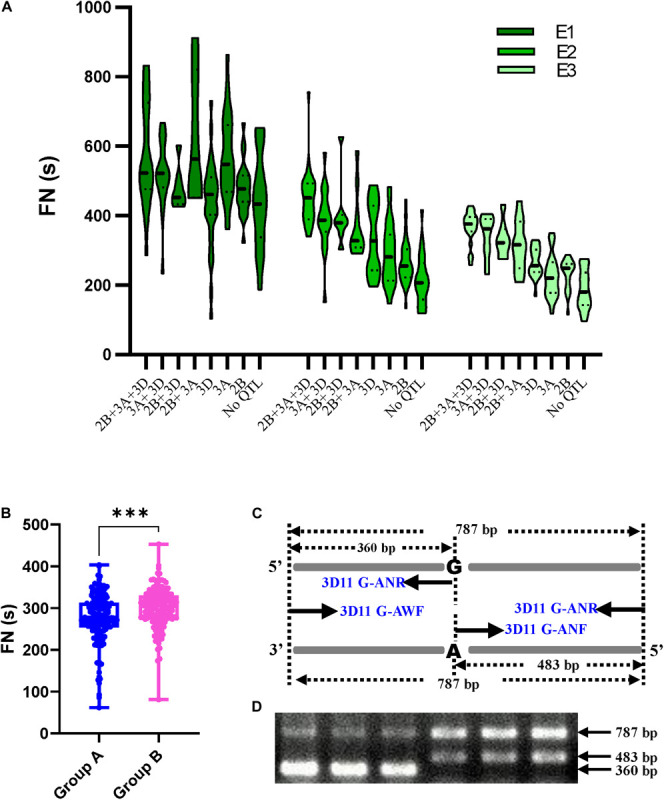
The effects of major QTLs for FN and marker development. (A) Effects of QTL combinations on FN of RILs in different environments shown by violin plot. (B) The effects of QFN.cib-3D on FN in RILs derived from Chuanmai 42 × Kechengmai 4. Group A denotes alleles that are the same as those of Kechengmai 4 and Chuanmai 39; group B denotes alleles that are the same as those in Chuanmai 42. (C) The principle of PCR-CTPP for QFN.cib-3D. “A” and “G” denote the SNPs in QFN.cib-3D. Four primers 3D11G-ANF, 3D11G-ANR, 3D11G-AWF, and 3D11G-AWR were applied in PCR. (D) Two patterns of PCR-CTPP amplification in RILs derived from Chuanmai 42 × Kechengmai 4. ∗∗∗Significant difference (p < 0.001) in FN between group A and group B.